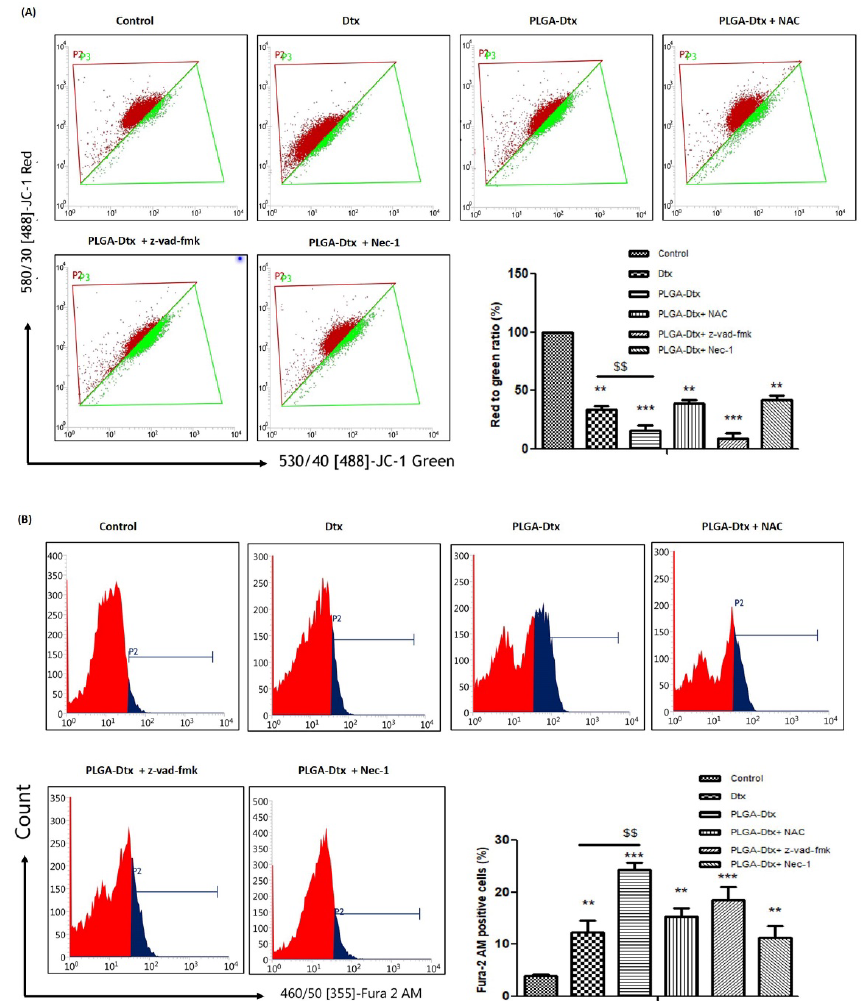
Figure 5. PLGA-Dtx-induced accumulation of reactive oxygen species is accompanied by mitochon- drial depolarization and calcium build-up. ( A ) A549 cell lines were pretreated with the free radical scavenger NAC or Z-VAD-fmk or Nec-1 and subsequently treated with IC 50 value of PLGA-Dtx and relative dose of Dtx for 12 h and then stained with JC- 1 to analyze loss of ΔΨm. In control cells, JC - 1 dye accumulates in mitochondria and forms red fluorescent J-aggregates, reflecting high